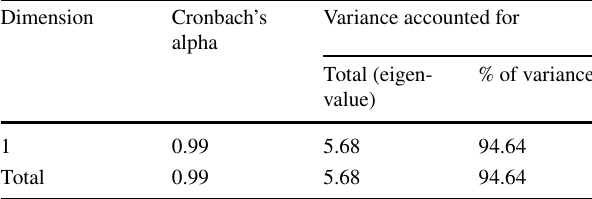
Table 7 Model summary of categorical PCA Dimension